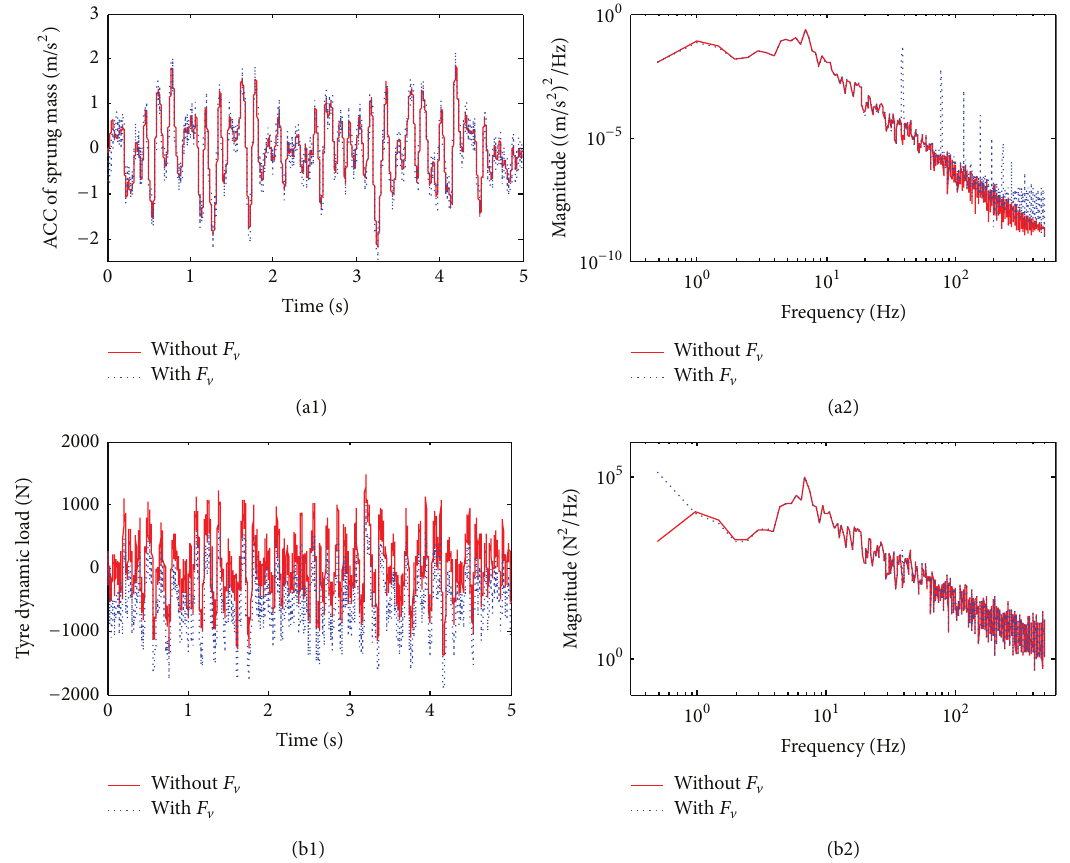
Figure 10: Suspension response to SRM vertical force at velocity 60 km/h. (a1) Time history of sprung mass acceleration. (a2) PSD of sprung mass acceleration. (b1) Time history of tyre dynamic load. (b2) PSD of tyre dynamic load.